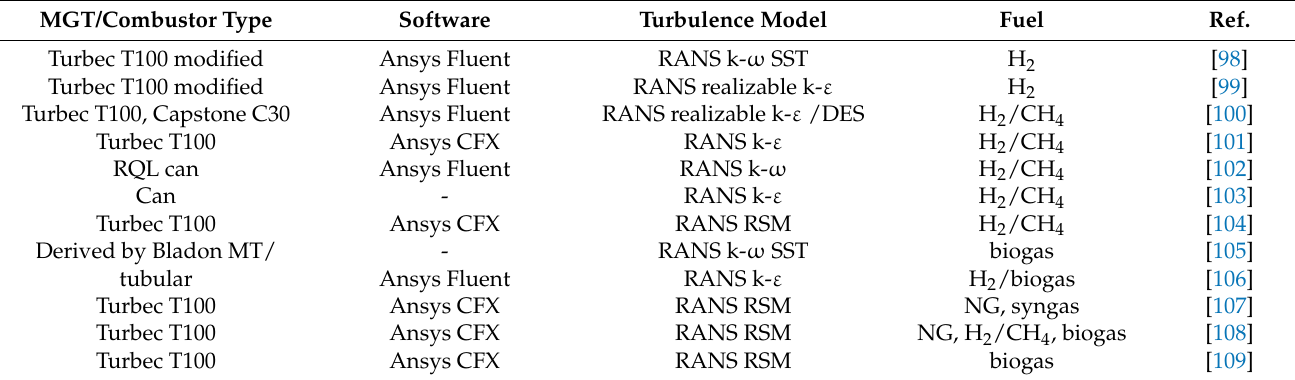
Table 8. CFD analysis on MGT supplied by unconventional